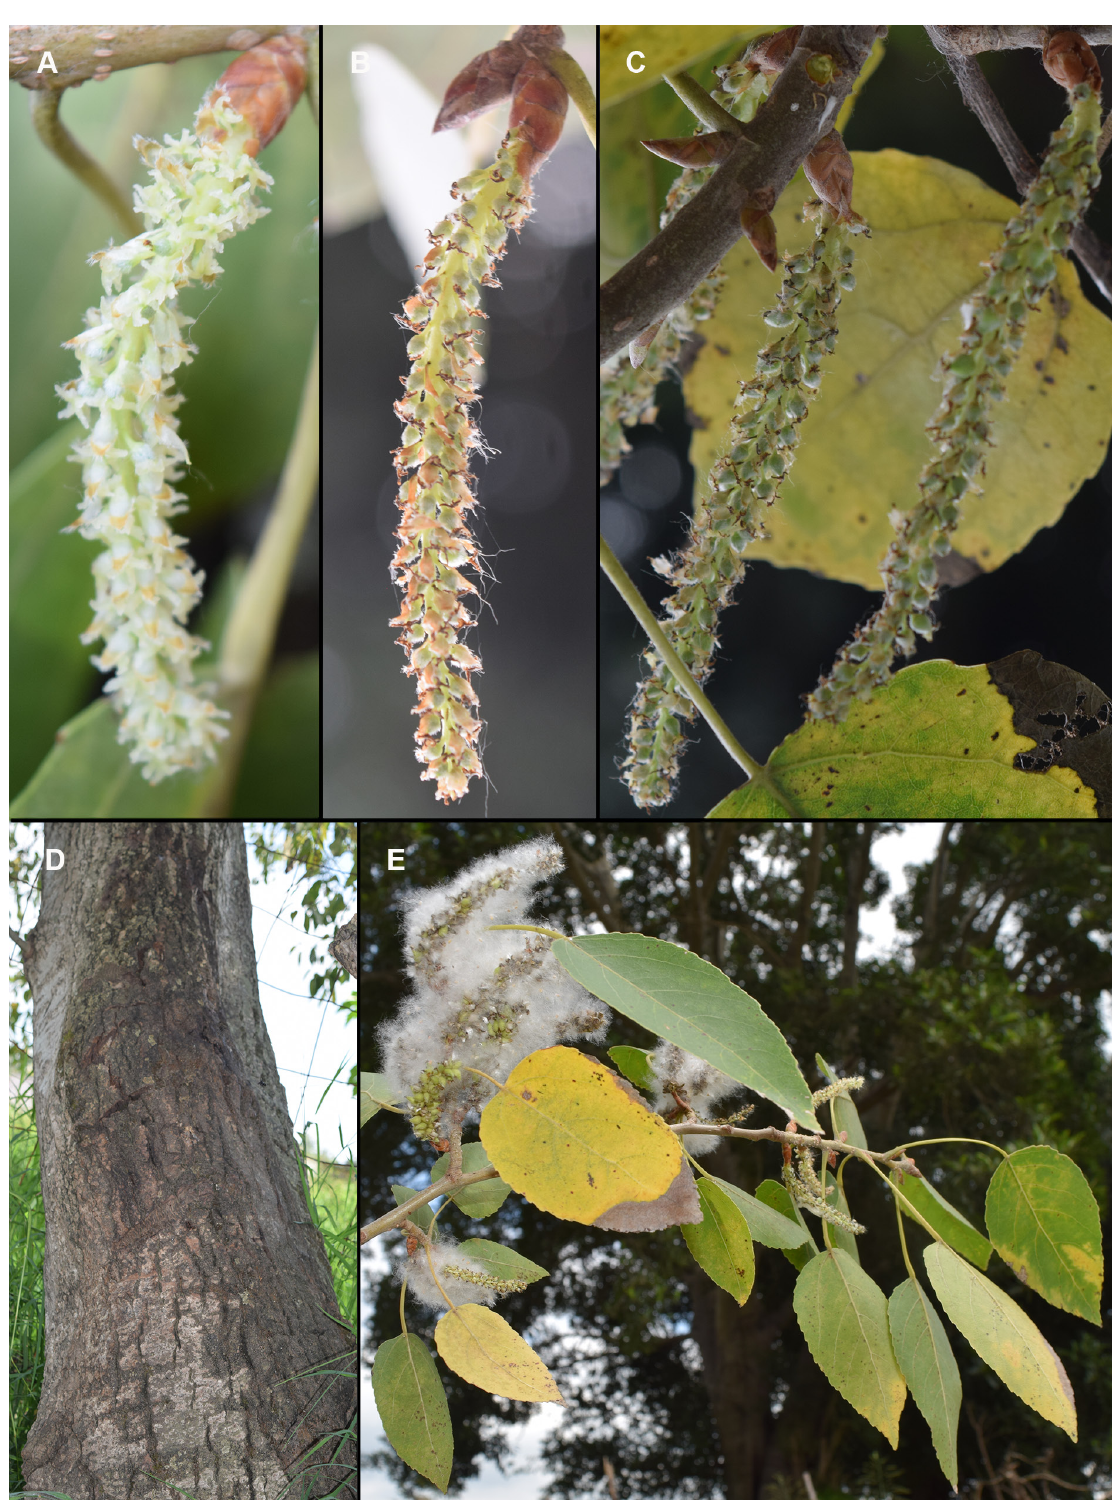
Fig. 4. Populus primaveralepensis A.Vázquez, Muñiz-Castro & Zuno sp. nov., fem ale individual, Vázquez-García et al. 10106c leg., IBUG. A. Inflorescence at anthesis. B . Inflorescence past anthesis. C . Developing infrutescence. D . Trunk. E . Branch with leaves and dehiscing capsules, showing the whitish pappus of seeds. Photographs: A.